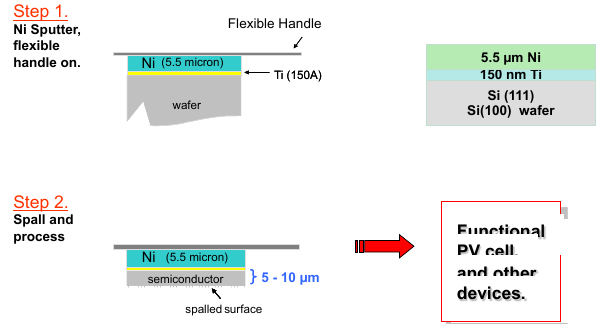
Figure 10. Handling and processing of spalled films for further applications such as solar cells (PV applications).